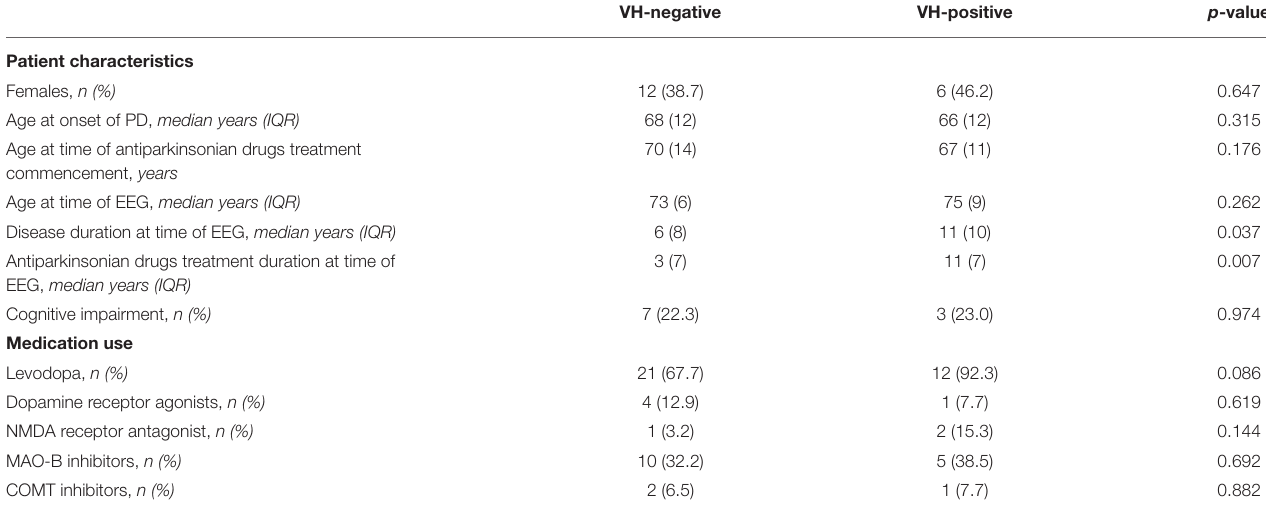
TABLE 2 | Patient characteristics and medication